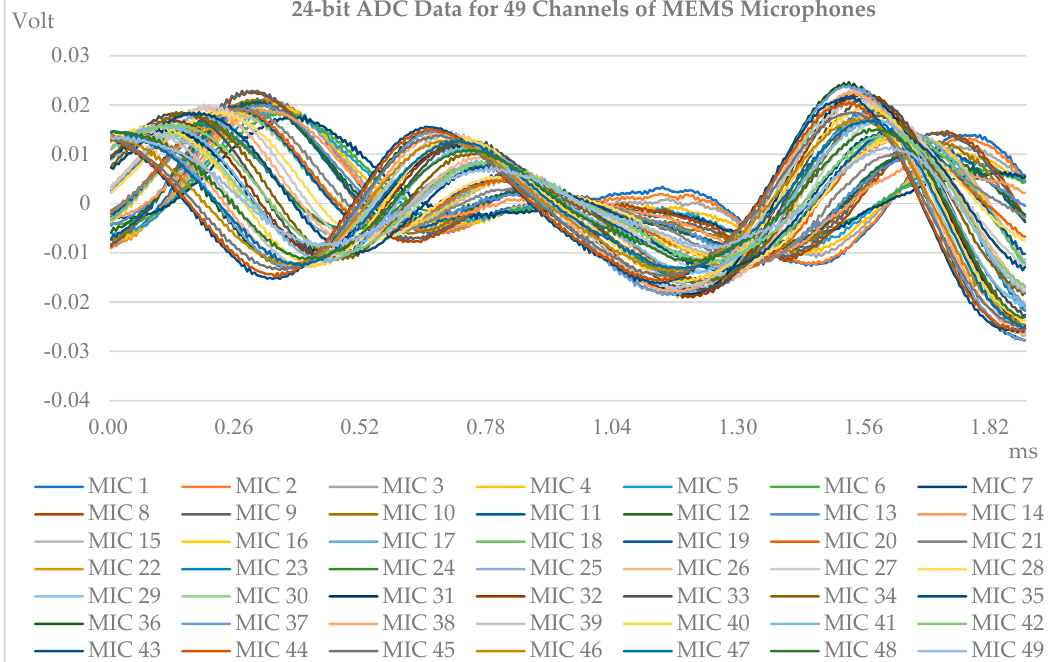
Figure 7. The 24-bit converted input signal voltages of 49 channels of MEMS microphones for an impulsive acoustic source generated by kicking a soccer ball.